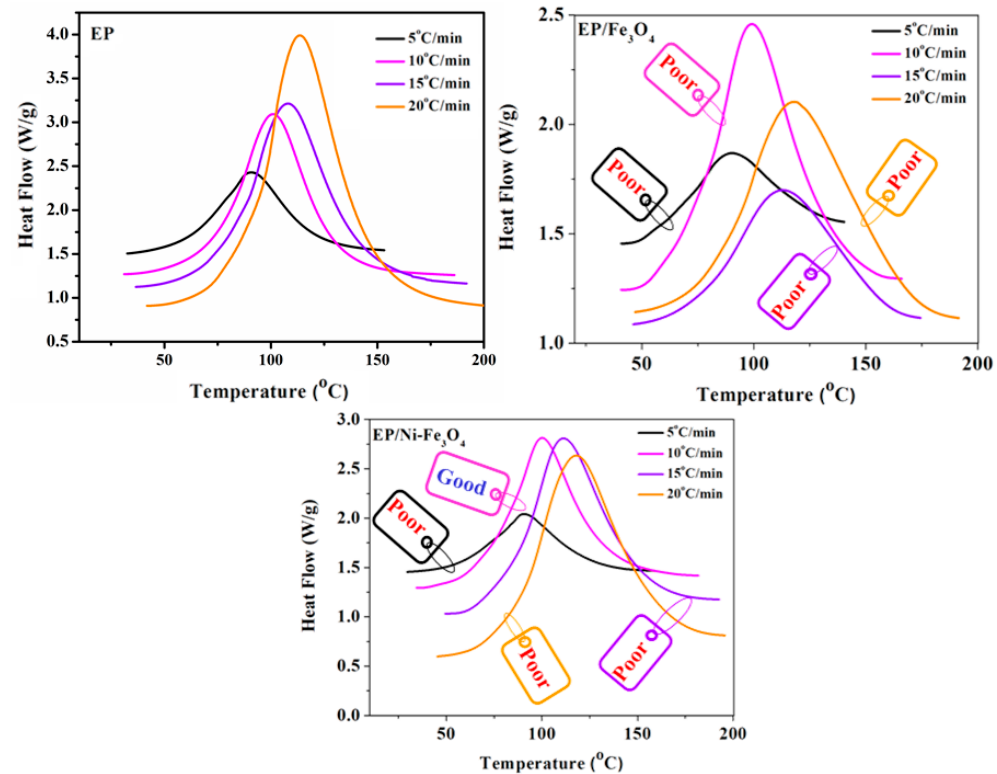
Figure 2. DSC profiles of epoxy (EP), EP / Fe 3 O 4 and EP / Ni-Fe 3 O 4 [13] nanocomposites at heating rates of 5, 10, 15 and 20 ◦ C / min, where epoxy (EP) and EP / Fe 3 O 4 are used as the control or reference samples.